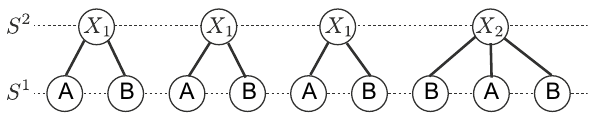
Fig. 7 Example of alphabet